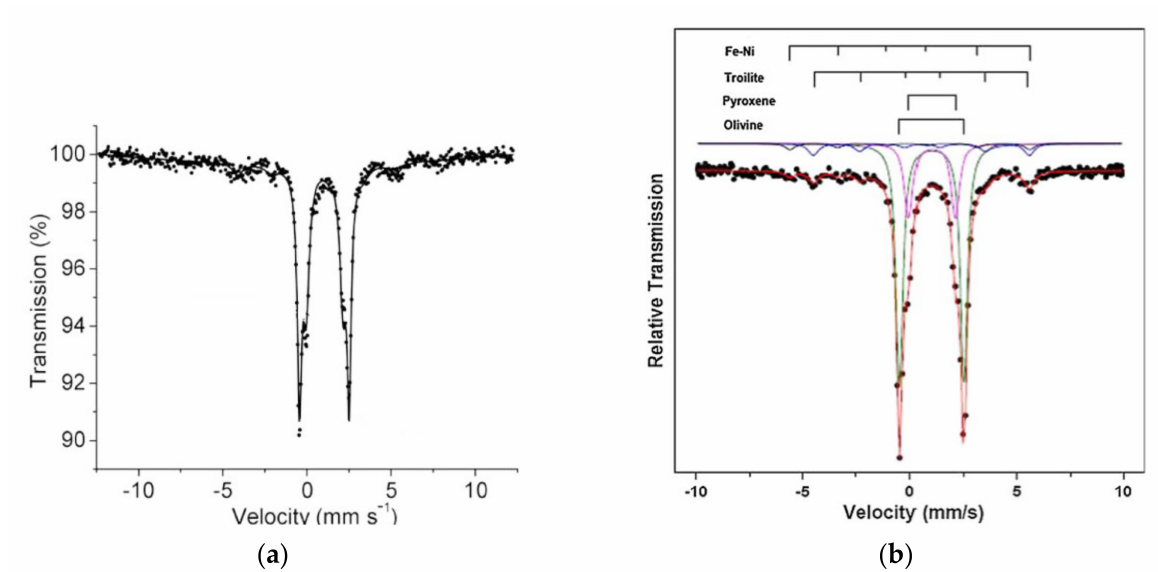
Figure 24. Room temperature Mössbauer spectra of ordinary chondrites Ararki L5 ( a ) and Varre-Sai L5 ( b ). Indicated components are the results of the fits. Adapted from References